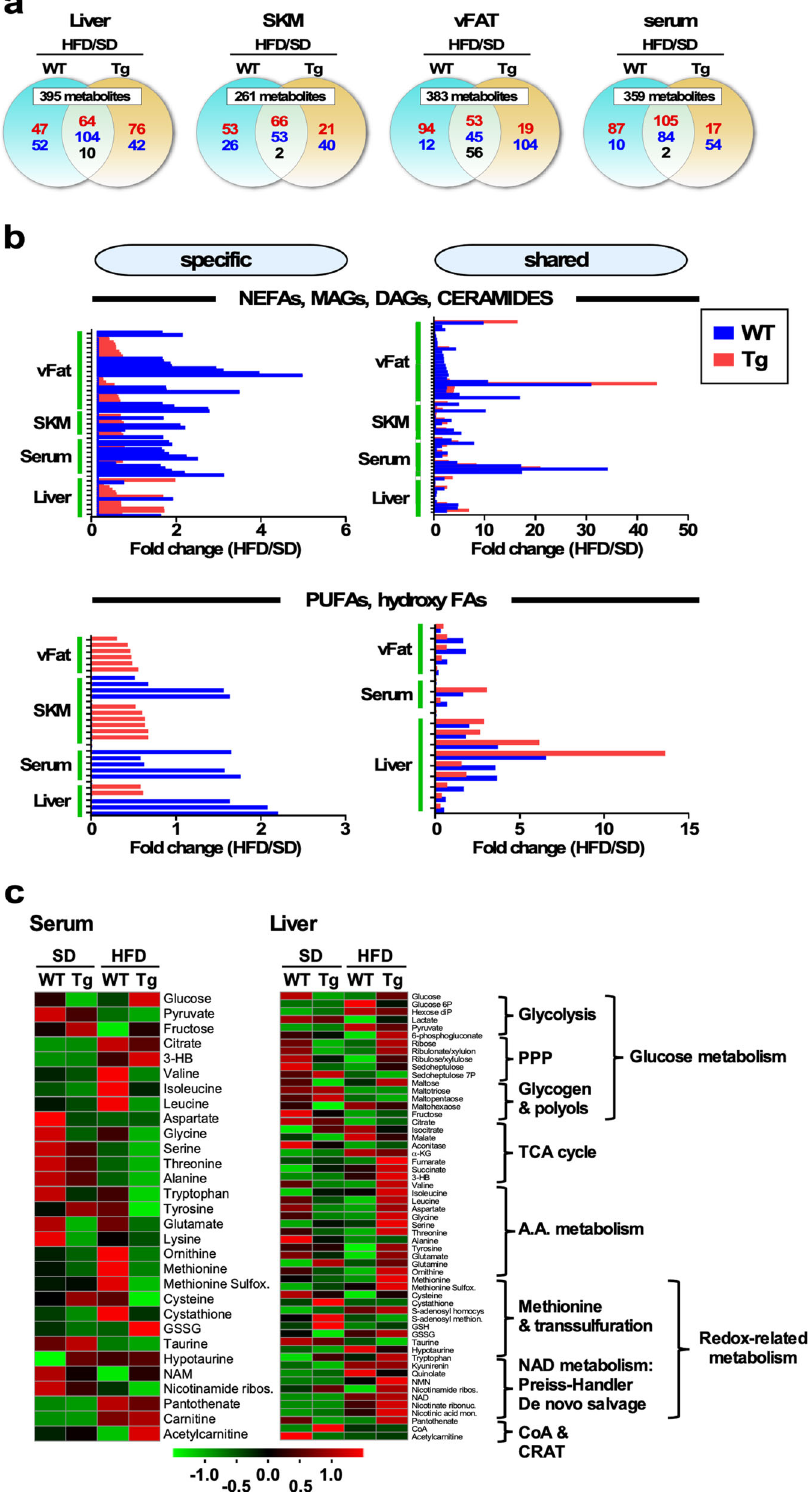
Fig. 5 Untargeted metabolomics analysis on the effect of global NQO1 overexpression in several tissues and serum of WT and NQO1-Tg mice-fed SD or HFD. a Two-way Venn-diagrams depicting the distribution of unique and common metabolites in WT and NQO1-Tg mice-fed HFD vs. SD. Untargeted metabolomics analysis was carried out in liver, skeletal muscle (SKM), visceral WAT (vFAT) and serum. Upregulation (red font), downregulation (blue font), and reciprocal regulation (black font) of signi fi cantly impacted metabolites (de fi ned as fold-change >1.5 or <0.67) are depicted. b Distribution of various classes of lipids (e.g., NEFAs, MAGs, DAGs, ceramides, PUFAs, hydroxy FAs) in the indicated tissues and serum of WT and NQO1-Tg mice-fed HFD vs. SD. c Heatmap visualization of metabolites in serum (left) and liver (right) of WT and NQO1- Tg mice-fed SD or HFD. Upregulation (red font), downregulation (green